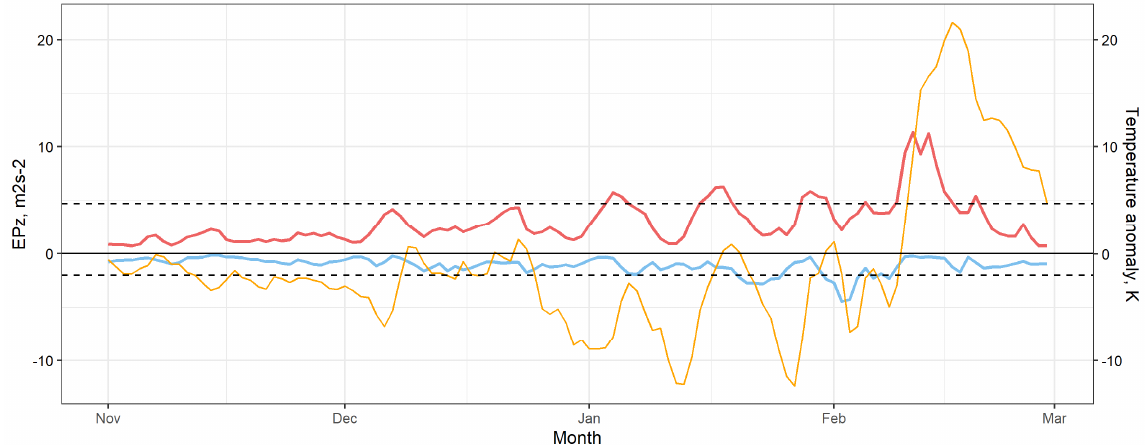
Figure 4. Upward ( red solid line ) and downward ( blue solid line ) EPz m and stratosphere polar cap temperature anomaly ( yellow solid line ) during the 2018 NDJF (year of the major SSW); the dashed horizontal lines show accordingly the 90th and 10th percentiles of EPz m .